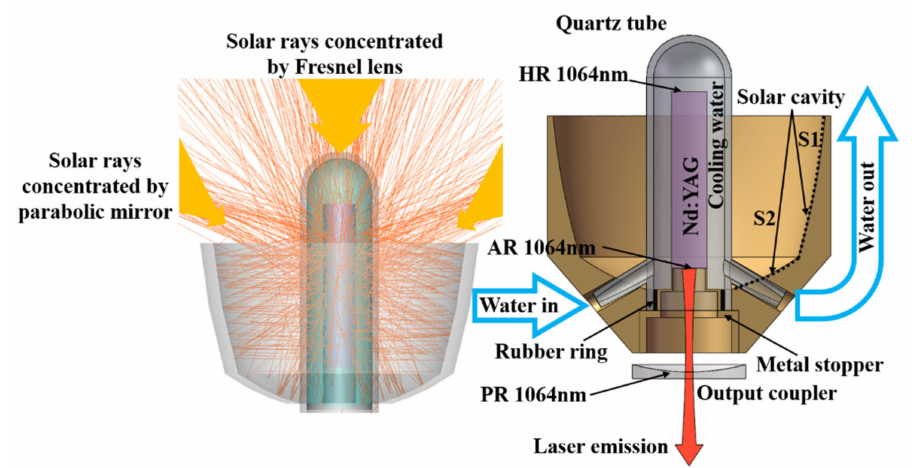
Figure 5. Liquid light-guide lens (LLGL) and dual-parabolic pump cavity containing 5-mm-diameter Nd:YAG rod. The incident solar light, 1064-nm laser resonator, water cooling scheme, and locations of the two parabolic surfaces in the solar cavity are illustrated.